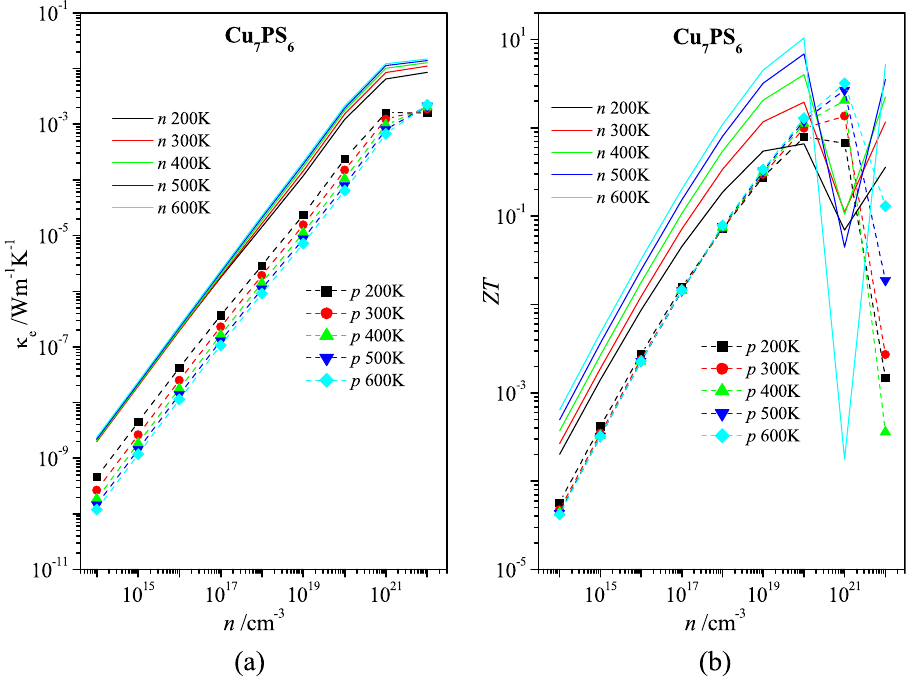
Figure 6. Dependences of ( a ) coefficient of electron thermal conductivity κ e and ( b ) figure of merit ZT on carrier concentration n for